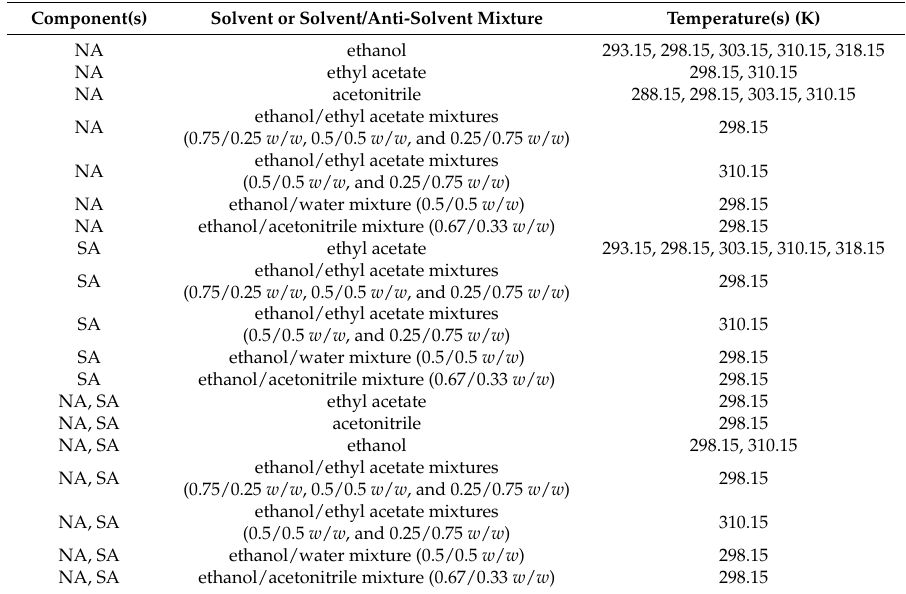
Table 1. Performed solubility measurements of nicotinamide (NA), succinic acid (SA) and mixtures of both in solvents or solvent/anti-solvent mixtures at specific